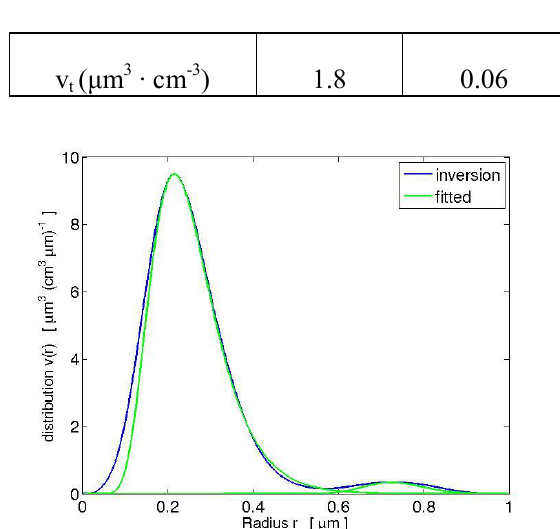
Fig 3: Retrieved volume distribution and log- normal fits for the fine and coarse aerosol mode.